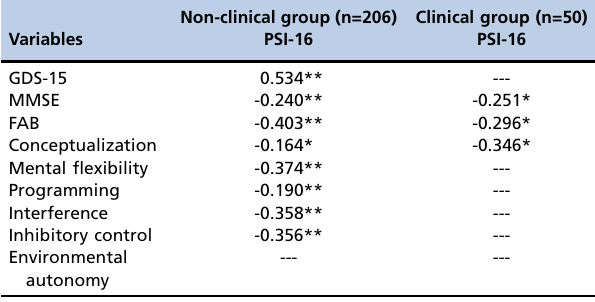
Table 4 - Correlation of the PSI-16 with the GDS-15, MMSE, and FAB in the Non-Clinical and Clinical